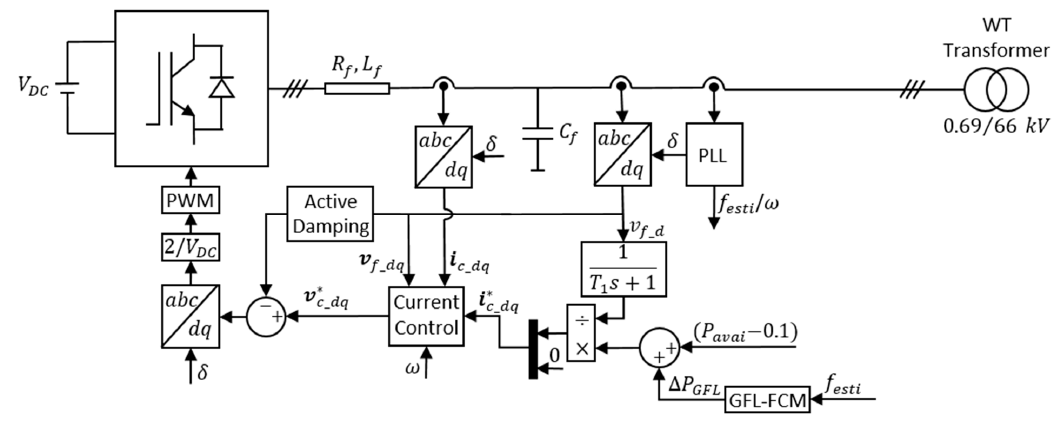
Figure 3. The GSC control scheme with the GFL-FCM.